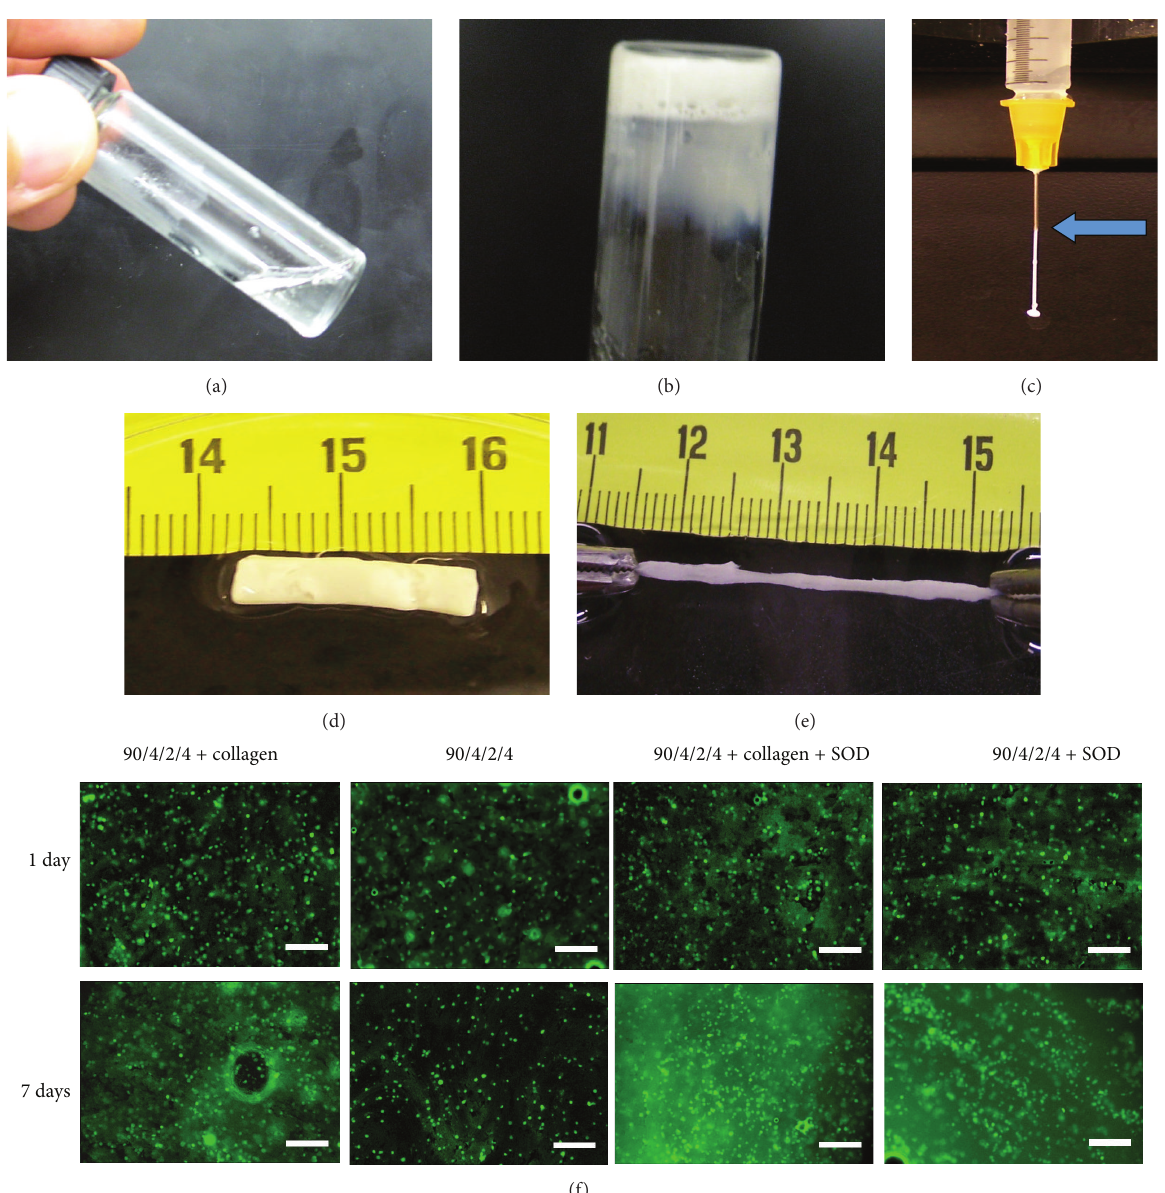
Figure 2: Macroscopic images of hydrogel and cells. The copolymer solution is flowable at 4 ∘ C (a) and forms gel after gelation at 37 ∘ C (b). The copolymer solution can be injected through a 26-gauge needle (c). At 37 ∘ C, the formed gel is flexible and can be stretched: (d) before stretching; (e) after stretching; (f) fluorescence images of MSCs encapsulated in hydrogels with or without collagen and superoxide dismutase (SOD, 4mg/mL) after 1 and 7 days of culture. The cells were stained with live cell stain CMFDA before encapsulation. Scale bar = 100 𝜇 m. This figure is adopted from